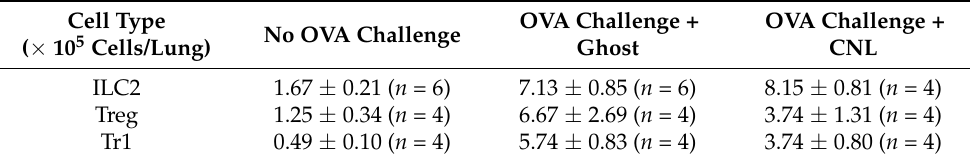
Table 1. Effects of ceramide nanoliposomes (CNL) on the number of ILC2, Treg, and Tr1 cells in lung tissues. OVA-sensitized mice were challenged with OVA-free PBS or OVA. OVA-challenged asthmatic mice were treated with 30 µ g/animal ceramide-free Ghost or CNL. Cell numbers of ILC2, Treg, and Tr1 cells isolated from lungs were determined. Data are shown as mean ± S.E.